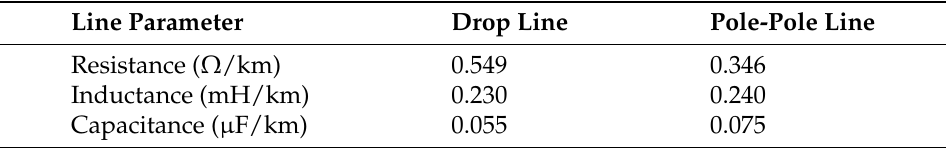
Table A2. Parameters for single phase PI section